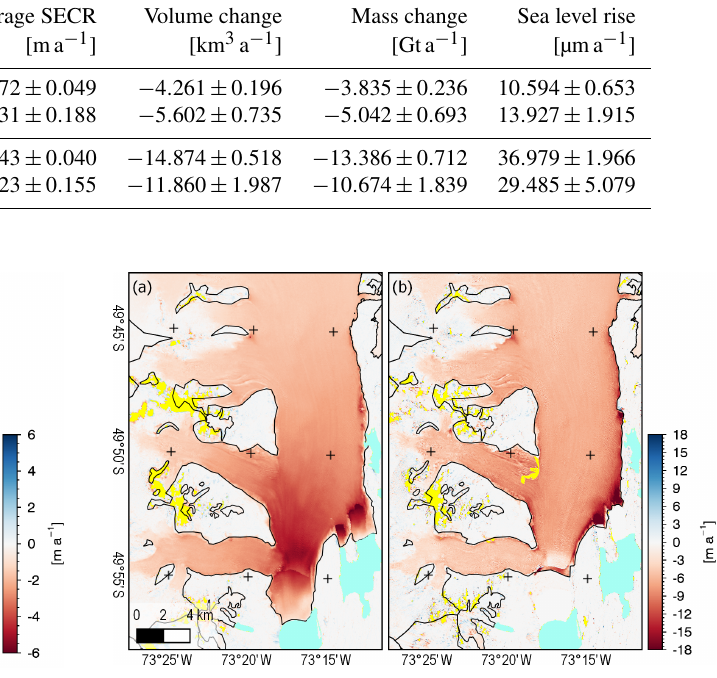
Figure 2. SECR of San Quintín: (a) 2000–2012, (b) 2012–2016.